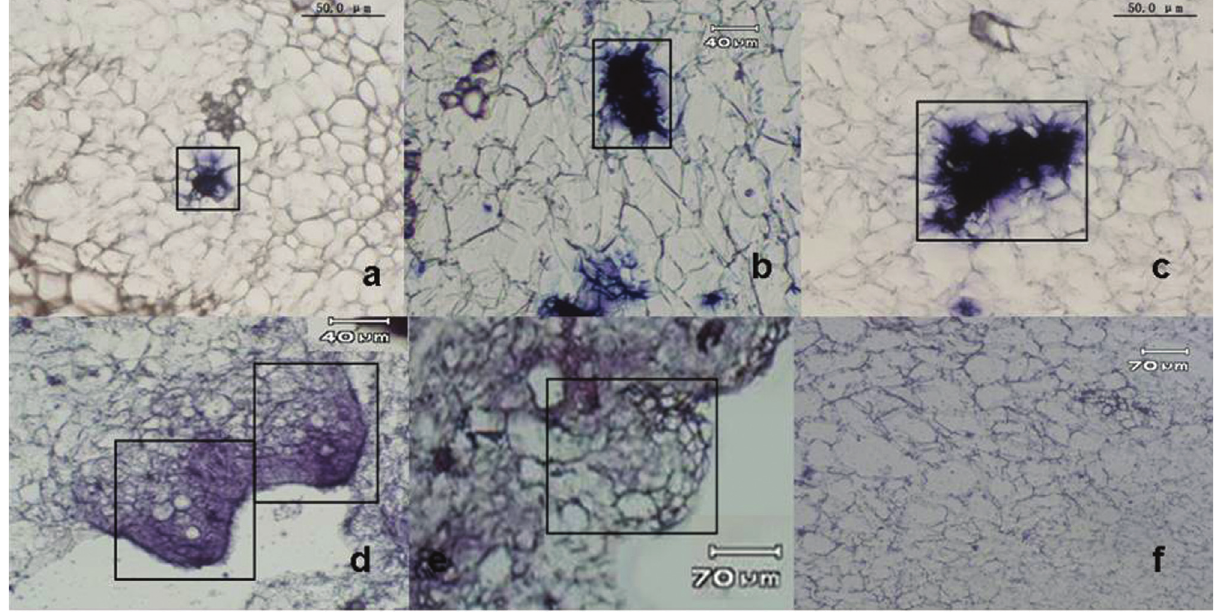
Figure 1 - In situ hybridization analysis of AcSERK3 during embryogenesis in pineapple. (A) Single competent cell with intense hybridization signal; only a few of the small cytoplasm-rich cells showed AcSERK3 expression. (B) Two competent cells with an intense hybridization signal that may have originated from one competent cell. (C) Cell clusters with an intense hybridization signal. (D) An early-stage pro-embryo with a very weak hybridization signal. (E) An early-stage globular embryo with no hybridization signal. (F) Negative control with no hybridization